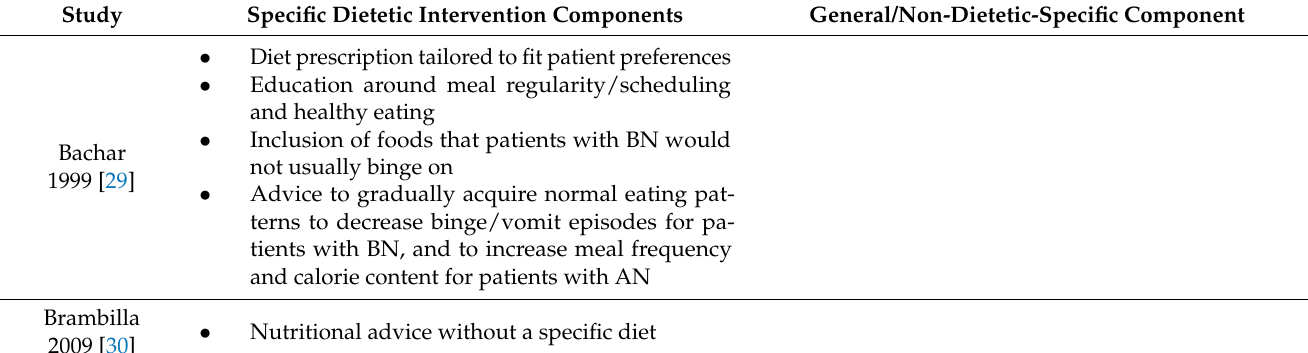
Table 2. Components of intervention delivered by a dietitian in the dietetic arm of the study. Study Specific Dietetic Intervention